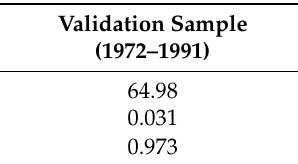
Table 1. Performance criteria for the simulated